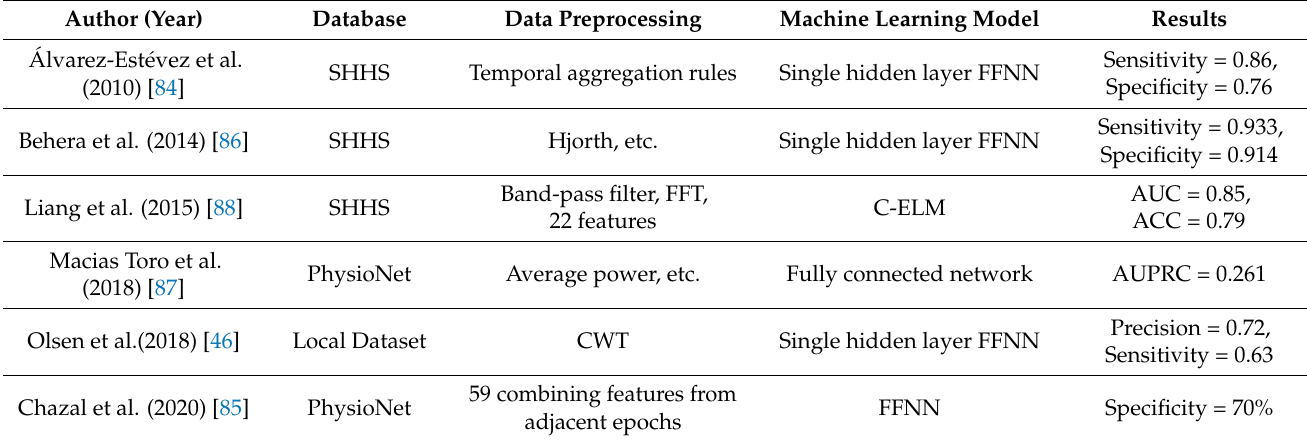
Table 4. Summary of the methods reviewed in this